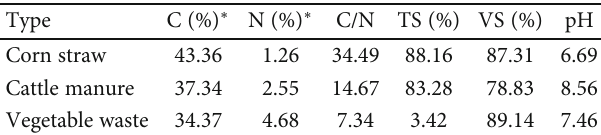
Table 1: Fundamental characteristics of corn straw, cattle manure, and vegetable